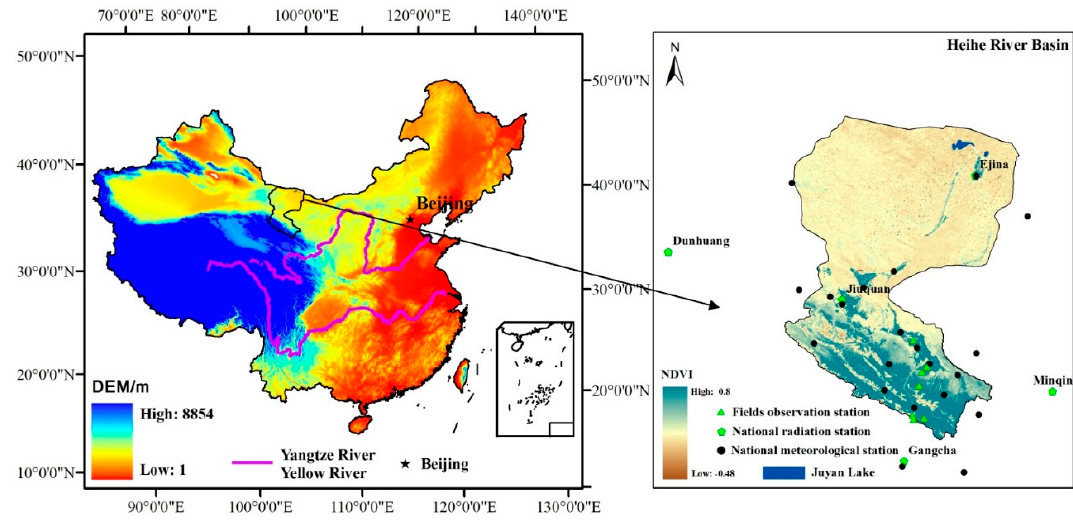
Figure 1. Location and physiography of the Heihe River Basin.